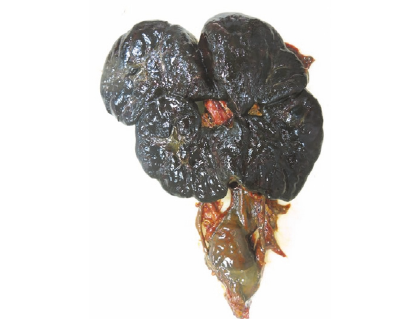
Figure 1: Photograph showing a horse shoe